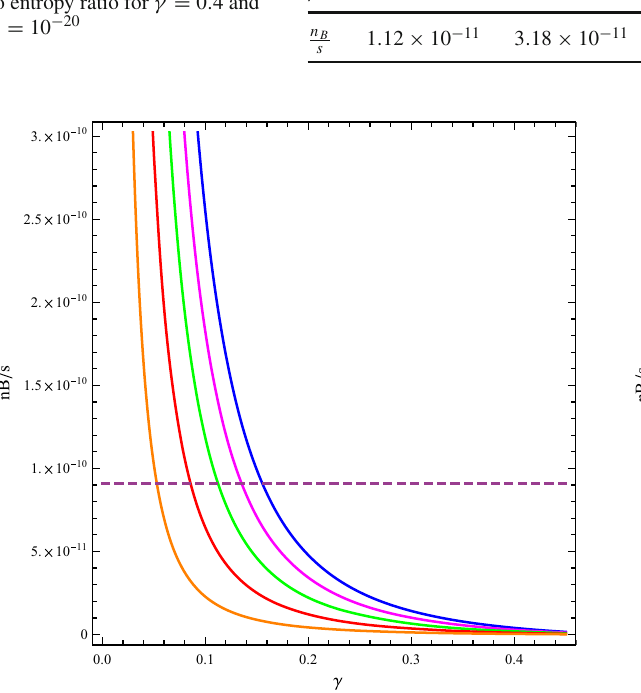
Table 1 Some values of baryon to entropy ratio for γ = 0 . 4 and